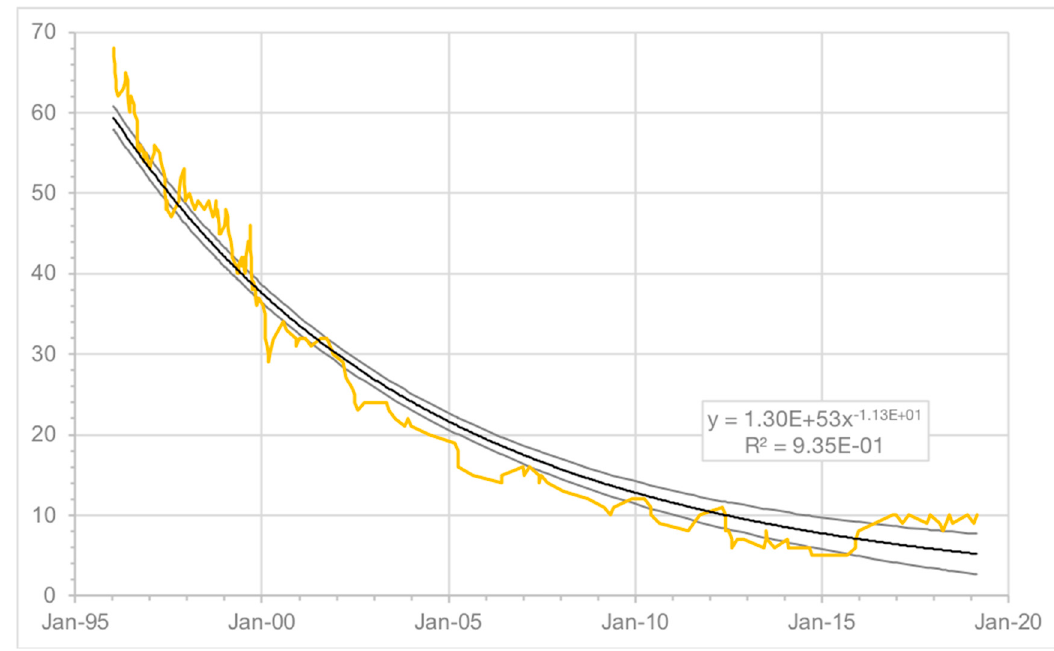
Figure 5. Population of cats documented on UCF campus, 1996–2019 (power fit and 95% confidence intervals shown in gray).